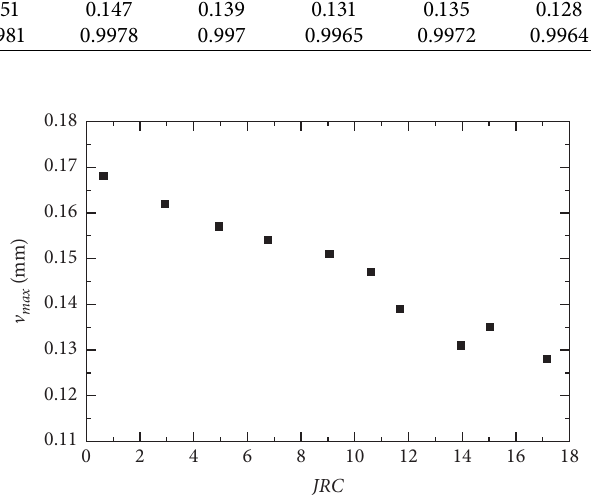
Figure 12: The variation of the joint maximum closure with